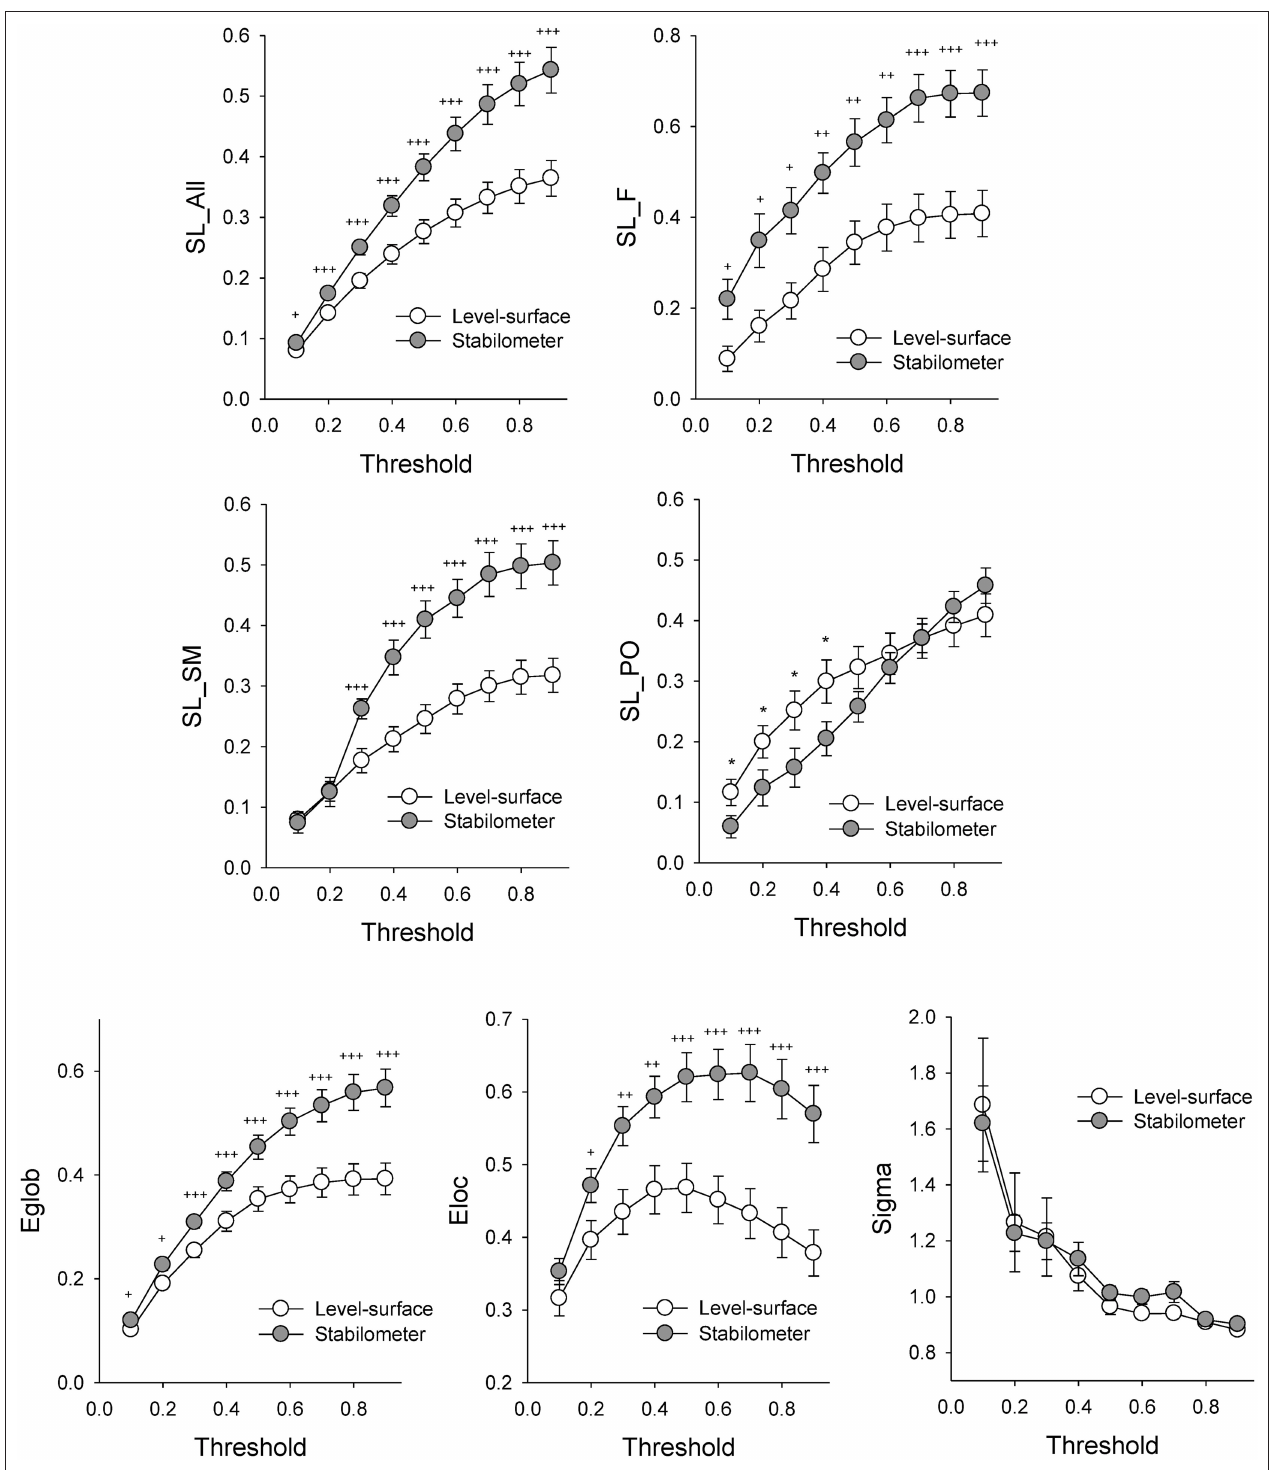
FIGURE 3 | The contrast of network parameters between the concurrent force-matching and postural tasks in the level-surface and stabilometer conditions at different threshold values. E glob , global efficiency; E loc , local efficiency; Sigma , small-world index; *, level-surface > stabilometer, p < 0.05; † , stabilometer > level-surface, p < 0.05; †† , stabilometer > level-surface, p < 0.01; ††† , stabilometer > level-surface, p < 0.001.